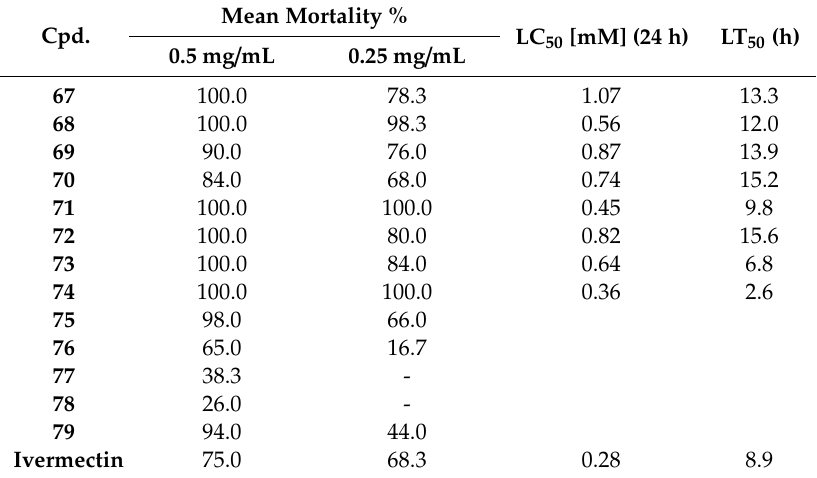
Table 10. Mean mortality percentages of Psoroptes cuniculi when incubated with 0.5 mg/mL and 0.25 mg/mL of different compounds [52].